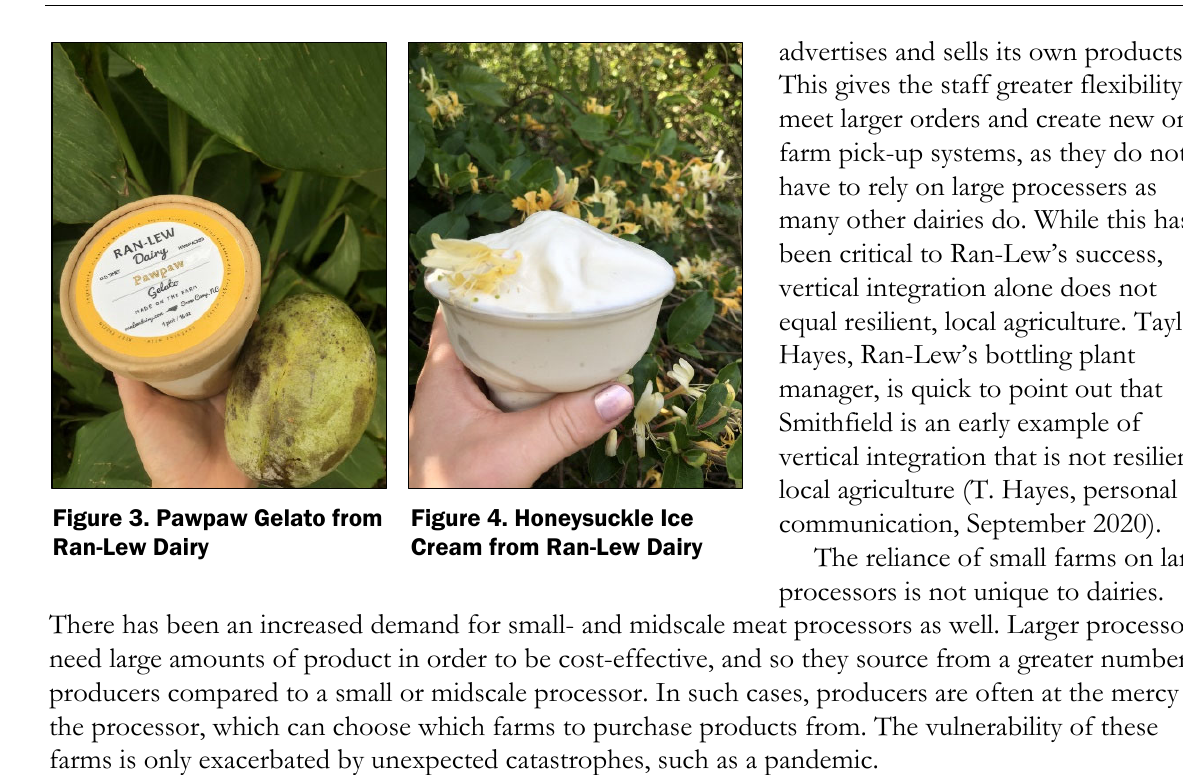
Figure 3. Pawpaw Gelato from Ran-Lew Dairy